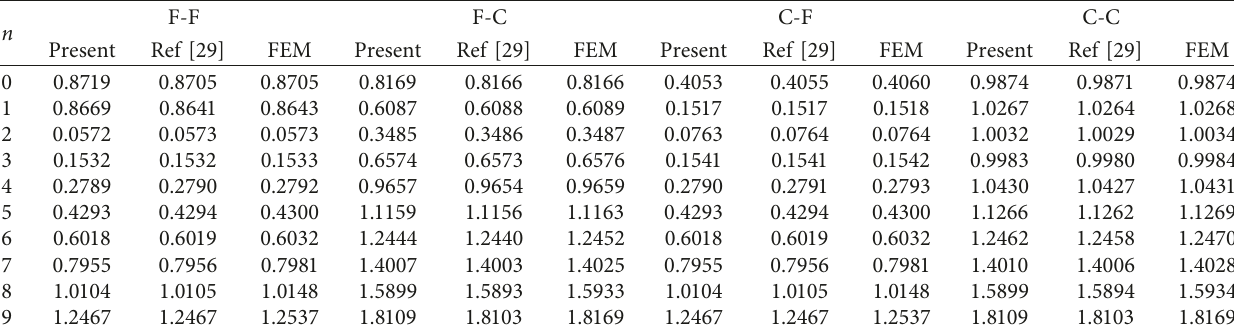
Table 3: Comparison of frequency parameter Ω with general boundary restraints.